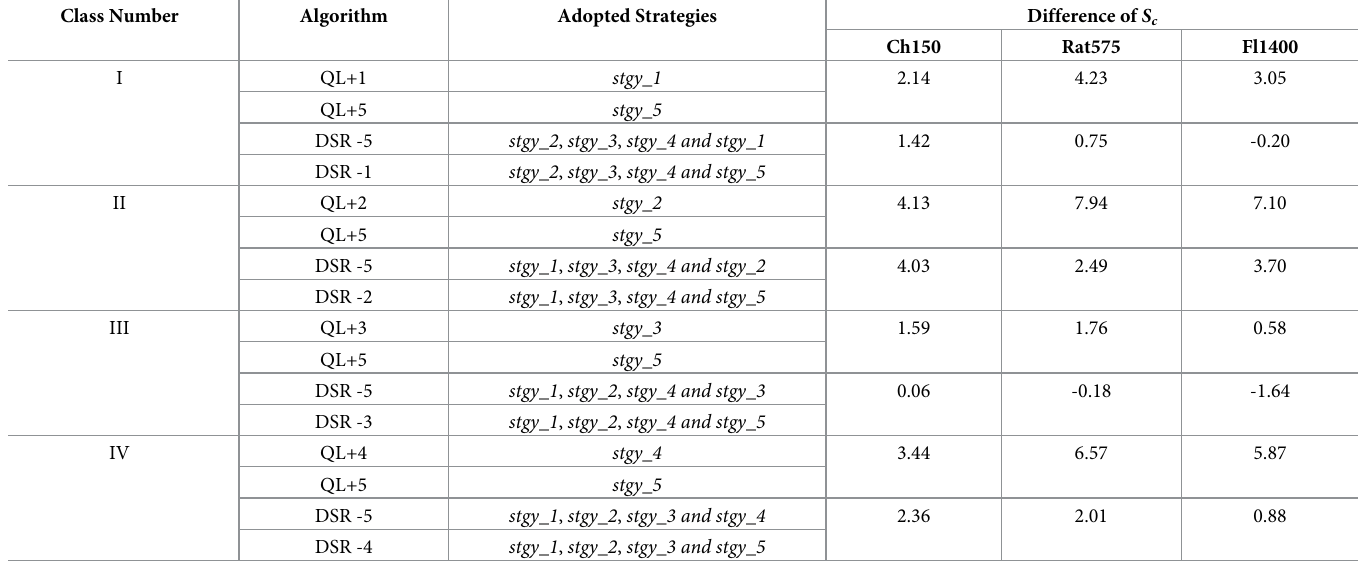
Table 8. The difference of S c between stgy_5 and stgy_1 ~ stgy_4 under collaboration or not. Class Number